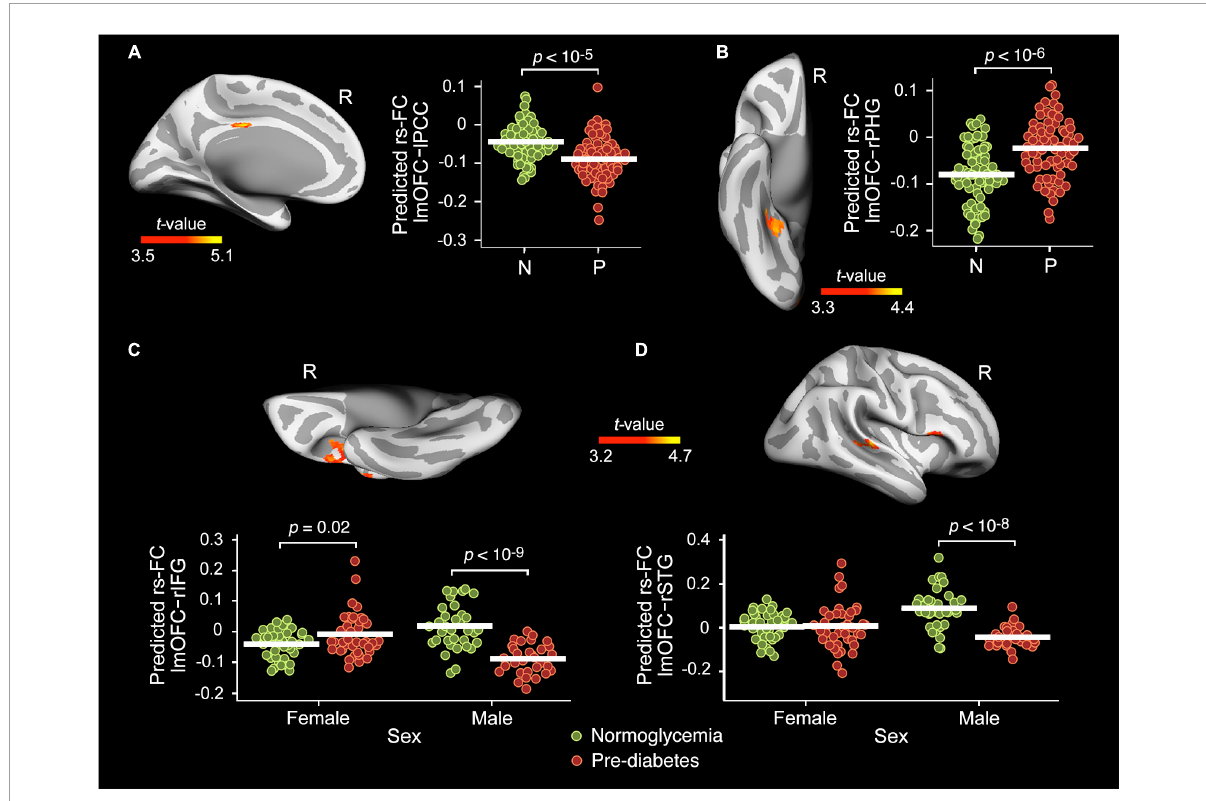
FIGURE2 Main effect of group and sex interaction on the resting-state functional connectivity (rs-FC) of the lmOFC. Main effect of group in the rs-FC of the left medial orbitofrontal cortex (lmOFC) with the left posterior cingulate cortex (lPCC) (A) and right parahipocampal gyrus (rPHG) (B) adjusted by age, sex, years of education, BMI, A/L ratio, HOMA, CRF, and MS status. Effect of group × sex interaction in the rs-FC of the lmOFC with the right inferior frontal gyrus (rIFG) (C) and right superior temporal gyrus (rSTG) (D) adjusted by age, years of education, BMI, A/L ratio, HOMA, CRF, and MS status. N, Normoglycemia; P,